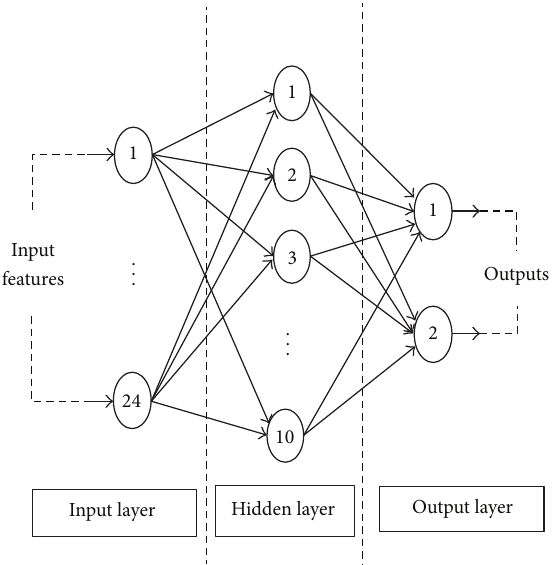
Figure 1: Structure of ELM